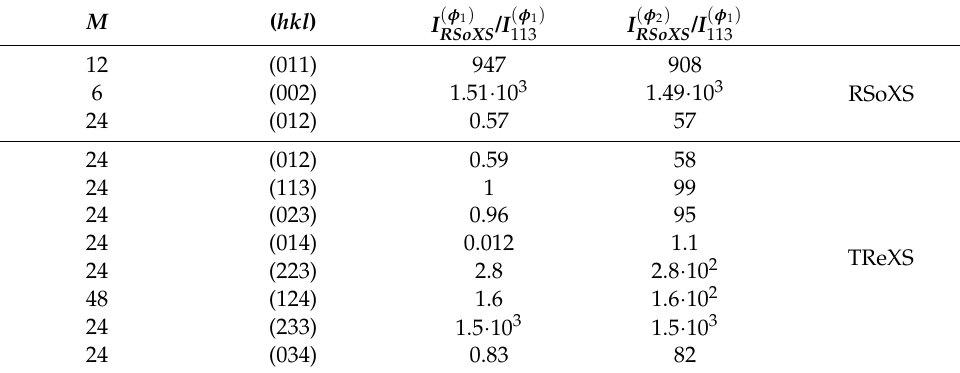
Table 4. Relative intensities of peaks with Miller indices ( hkl ) and multiplicity M , calculated at λ C = 4.4 nm (RSoXS) and λ S = 0.5 nm (TReXS) for the scatterer’s inclinations φ 1 = 0.01 ( I ( φ 1 ) ) and φ 2 = 0.1 ( I ( φ 2 ) ). Intensities are normalized with the intensity of the peak (113) at the scatterer’s ( φ 1 ) inclination φ 1 = 0.01 ( I 113